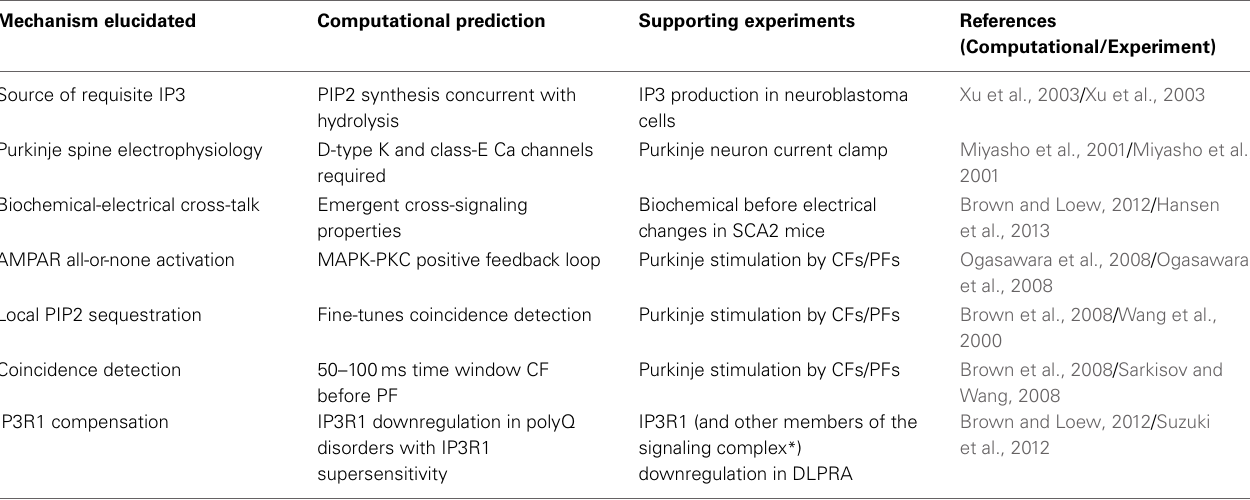
Table 1 | Examples of contributions of computational systems neurobiology to translational